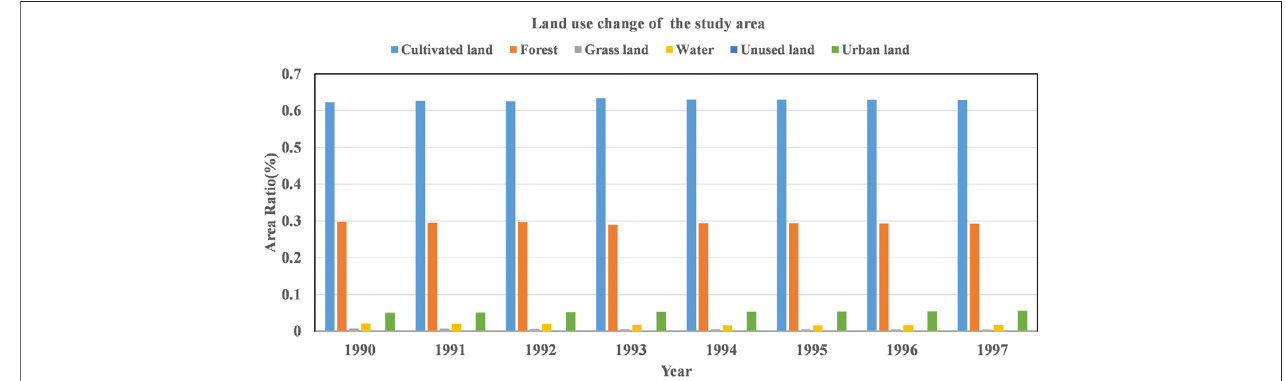
FIGURE 7 | Distribution of land-use area ratio of Xixian watershed.